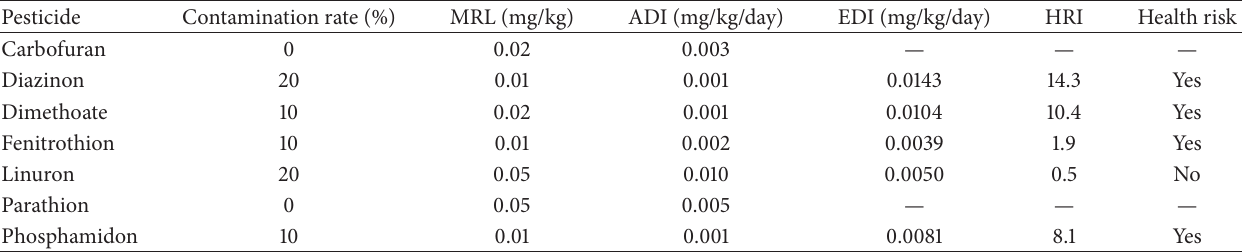
Table 2: Percentage contamination and HRI of the investigated pesticides for eggplant.